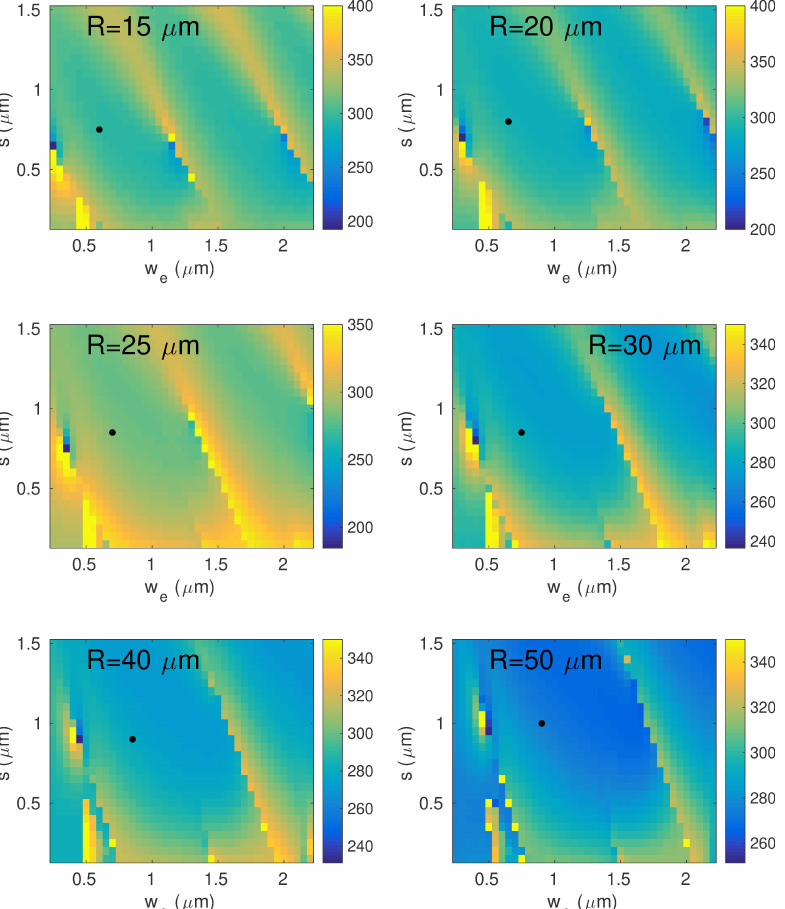
Figure 12. Sensitivity ( ∆ λ res / ∆ ( RIU )) of the principal TM mode for six different values of R : 15 µ m, 20 µ m, 25 µ m, 30 µ m, 40 µ m and 50 µ m al λ = 1550 nm, as a function of the design parameters w e and s . The positions corresponding to the maximal values of a are marked with black